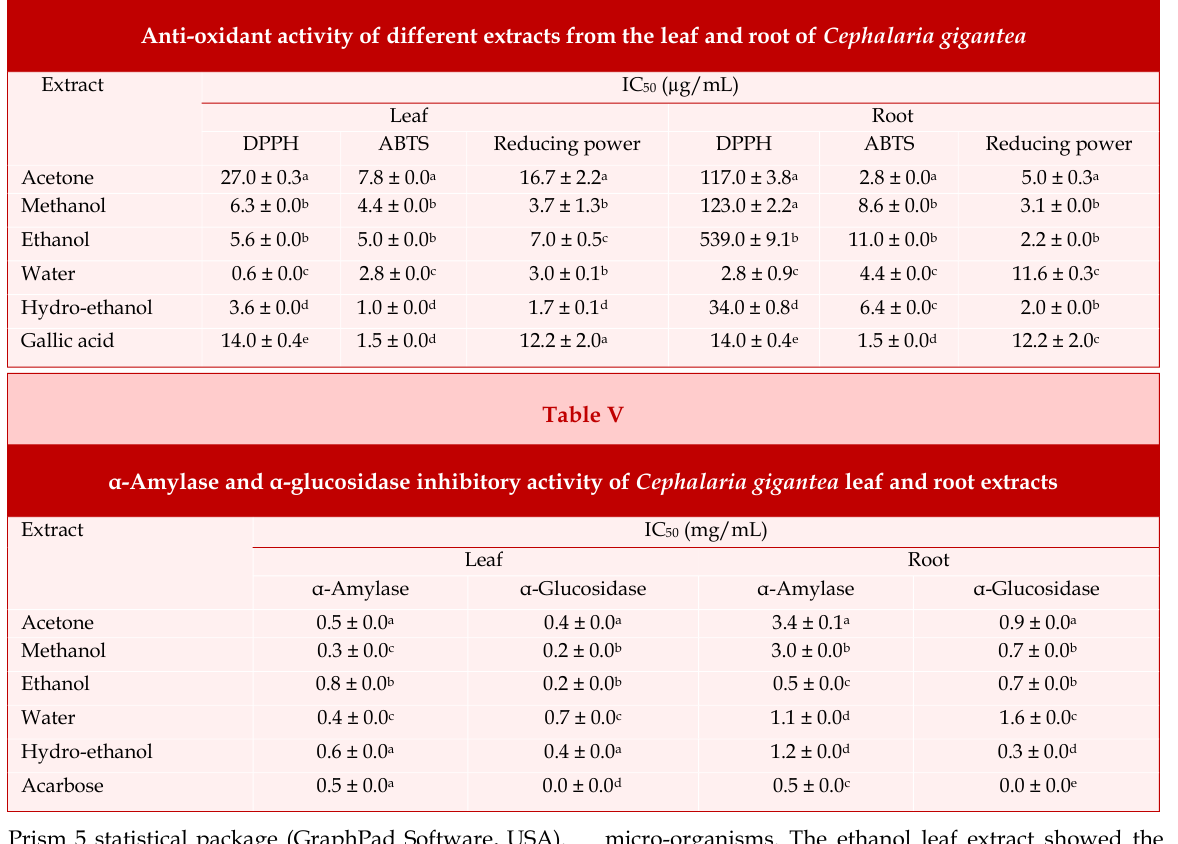
Anti-oxidant activity of different extracts from the leaf and root of Cephalaria gigantea